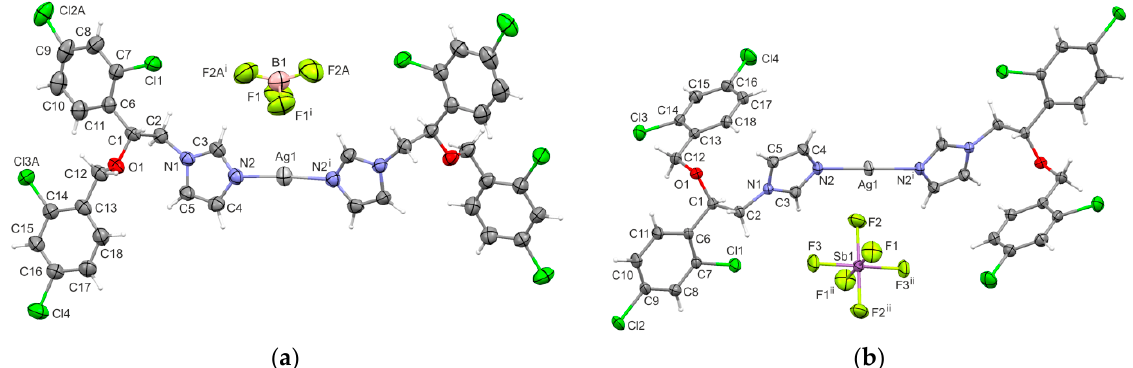
Figure 2. Molecular structures of Ag(I) complexes of miconazole with tetrafluoroborate ( 3 ) ( a ) and hexafluoroantimonate ( 4 ) ( b ) counter ions. The anisotropic displacement ellipsoids are drawn at the 30% probability level. For clarity, only the major components of the disordered atoms (F2A, Cl2A, Cl3A, H18) are shown. Symmetry codes: 3 (i) − x , y , − z + ½; 4 (i) − x + 1, − y + 2, − z + 1; (ii) x + 2, − y + 2, − z + 1.